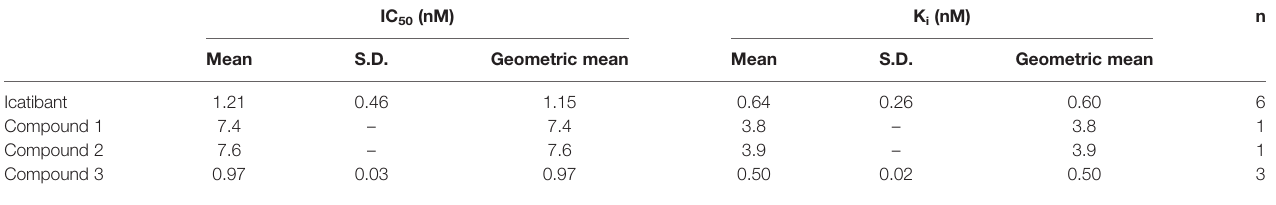
TABLE 1 | Af fi nities, IC 50 and K i values at the human B 2 receptor derived from the [ 3 H]BK binding competition assay. IC 50 (nM) K i (nM) n Mean